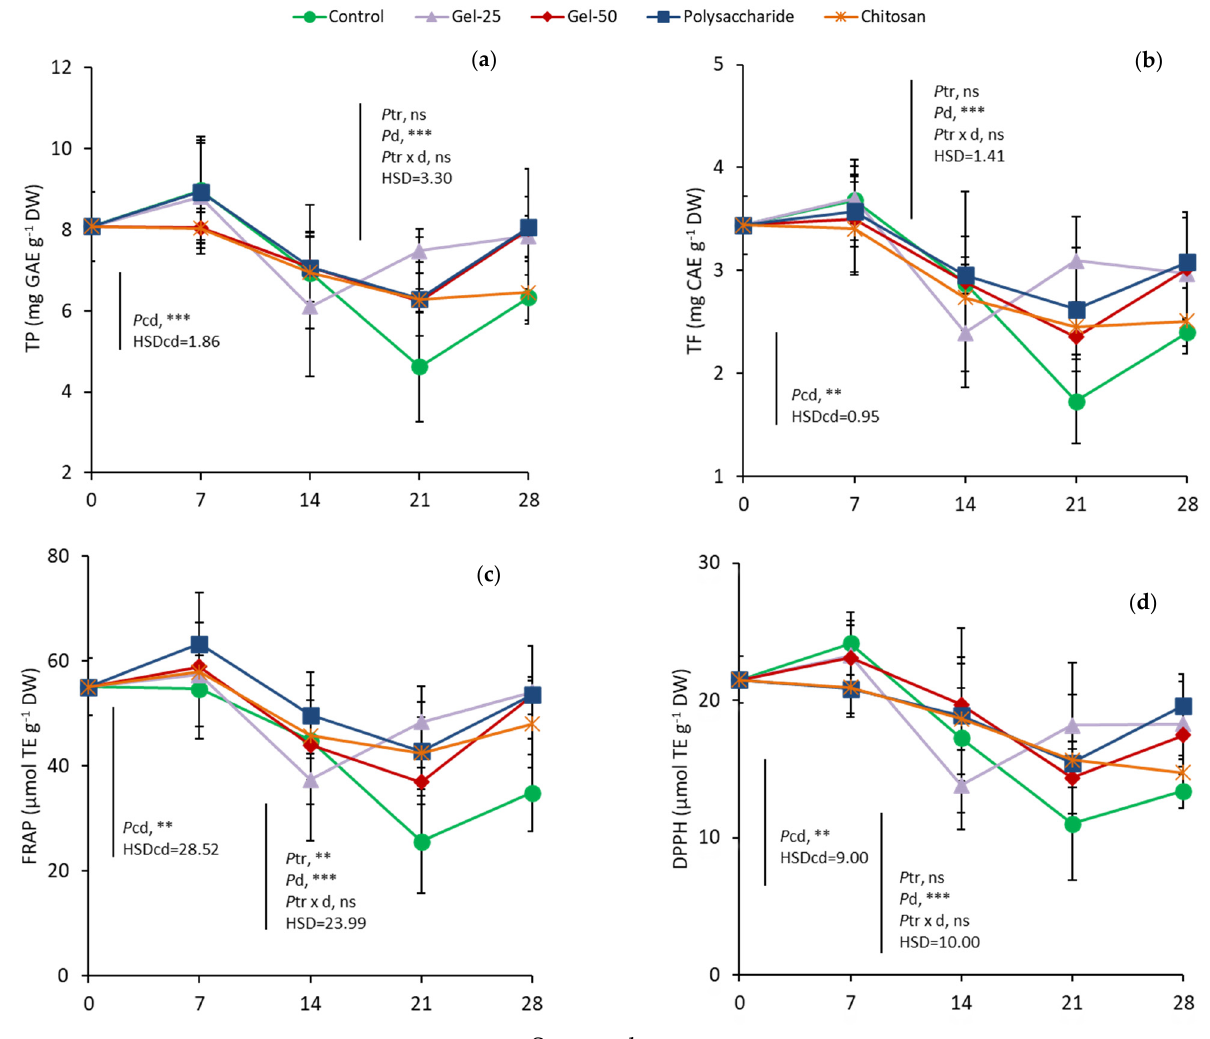
Figure 5. Effect of edible coatings on changes in total phenolic compounds ( a ), total flavonoids ( b ), total antioxidant capacity (TAC) determined by FRAP assay ( c ) and DPPH assay ( d ) in cherries during storage. Points are means of three replicates of 10 cherries each; bars on the points, ± standard deviations. NS, non significant; ** significant at p < 0.01; *** significant at p < 0.001. Pcd , probability of storage days in controls (one-way ANOVA from day 0); HSDcd, honest significant difference calculated from ANOVA. Ptr , probability of edible coating treatment; Pd , probability of storage days; Ptr × d , probability of interaction (two-way ANOVA from day 7); HSD, honest significant difference calculated from ANOVA.